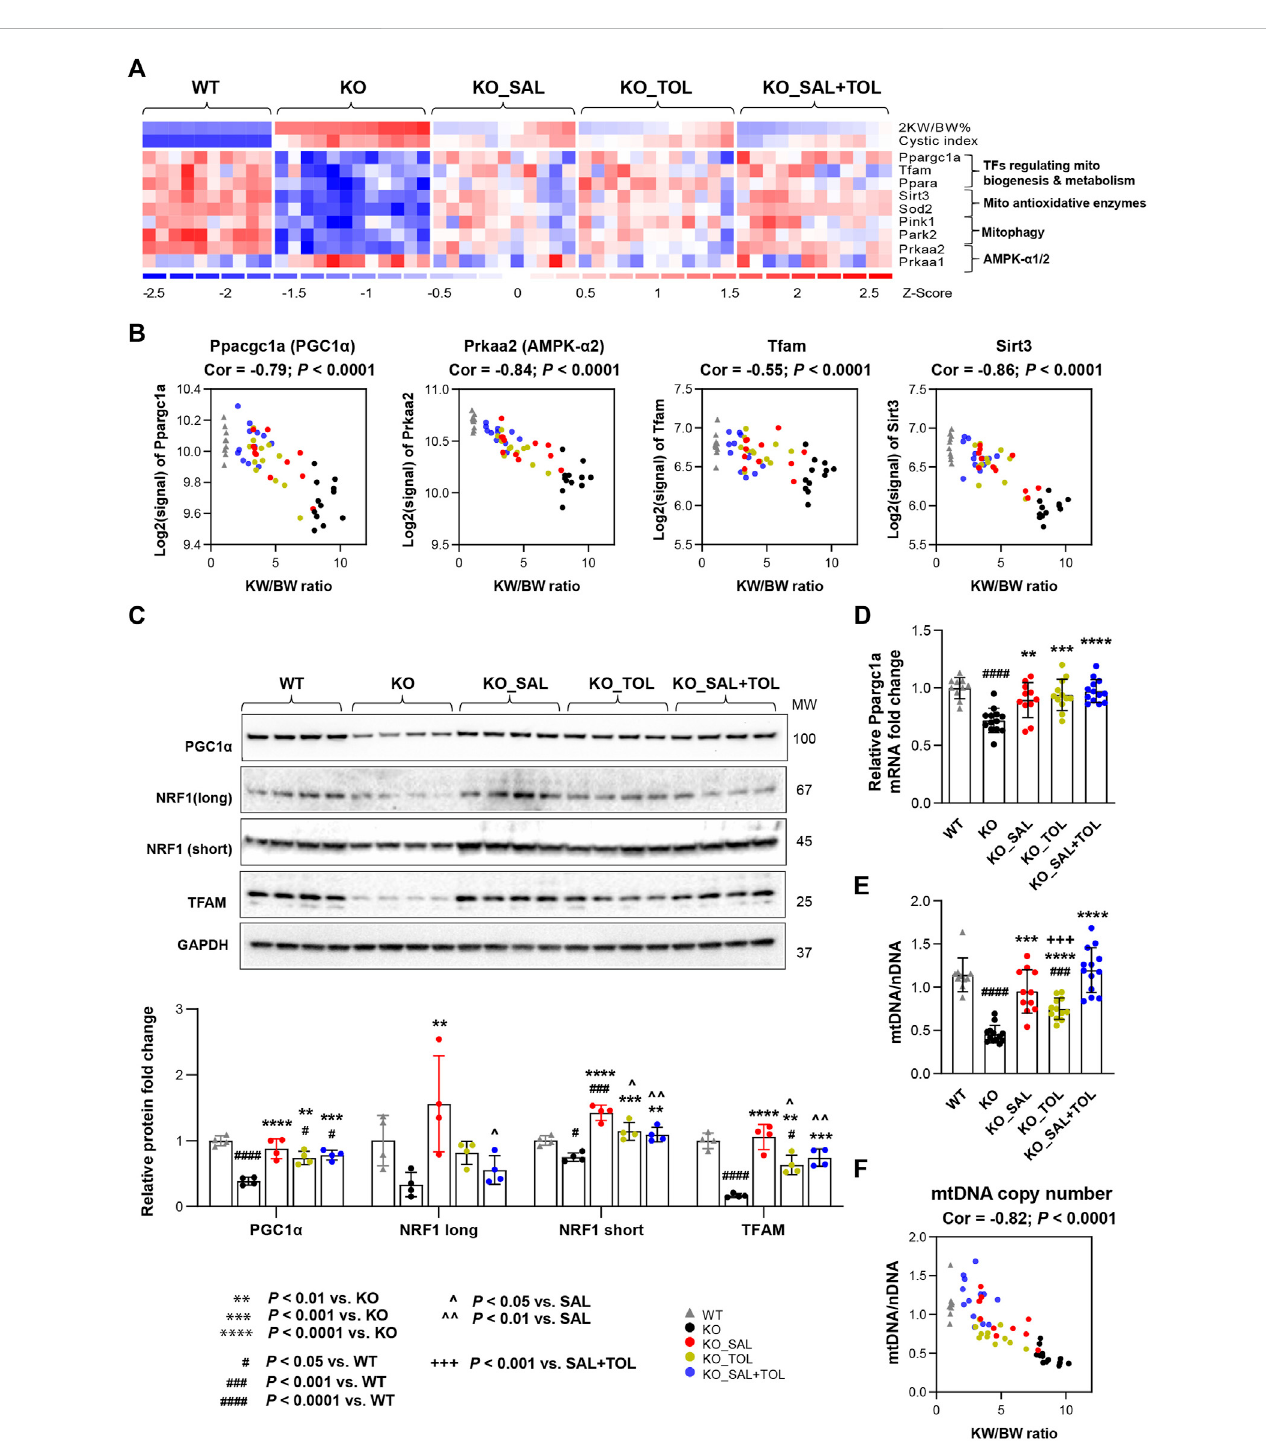
FIGURE 4 The combined treatment improved expression of components of metabolic pathways and mitochondrial DNA copy numbers in Pkd1 mutant kidneys. (A) HeatmapshowedthedecreasedmRNAexpressionforkeygenesinmitochondrialbiogenesis,metabolism,antioxidant,andmitophagyin Pkd1 mutantkidneys;all these changes were attenuated by treatments. (B) Transcript levels (microarray) of Ppargc1a , Prkaa2 , Tfam and Sirt3 inversely correlated with 2 KW/BW% in Pkd1 mutantkidneys. (C) RelativeproteinlevelsofPGC1 α ,NRF1andTFAMinWT,untreatedandtreatedmutantmousekidneysbyWesternblot.GAPDHwasused asaloadingcontrol. (D) RelativemRNAlevelsof Ppargc1a inWT,untreatedandtreatedmutantmousekidneysbyRT-qPCR. (E) RelativemitochondrialDNA copy numbersinWT,untreatedandtreatedmutantmousekidneysbyqPCR. (F) AninversecorrelationbetweenmtDNA/nDNAand2 KW/BW%in Pkd1